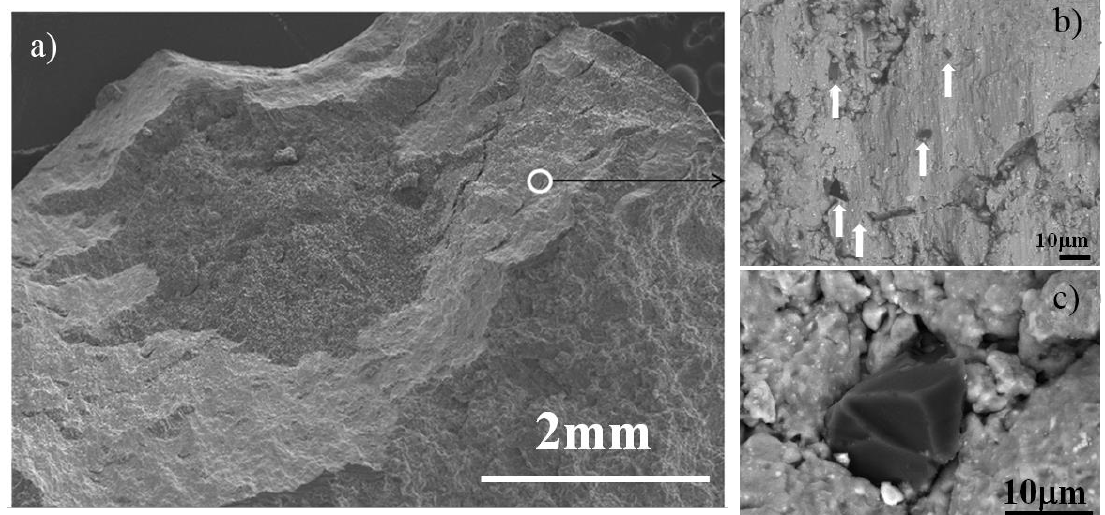
Figure 9. ( a ) Fracture surface examination of the Al2024-2.0 wt.% B 4 C composite milled for 2 h; ( b ) B 4 C particles on the fractured surface and ( c ) Fracture dimples around the B 4 C particles.